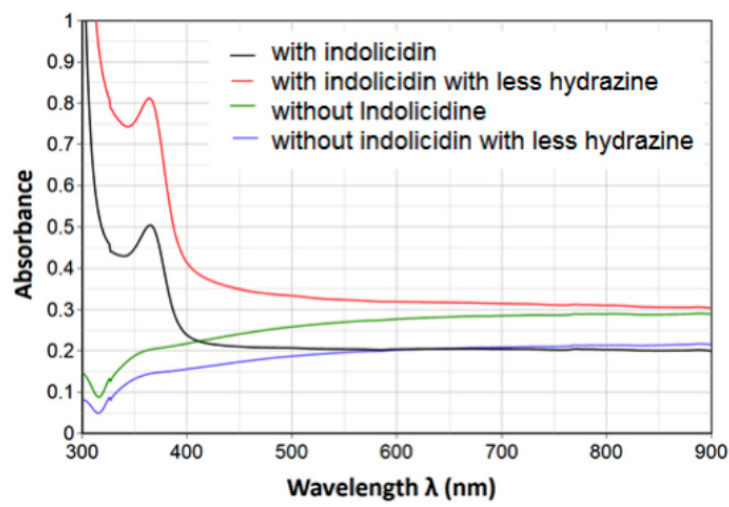
Figure 2. UV-Vis spectra of silver colloids prepared using 150 µ L and 10 µ L N 2 H 4 · H 2 O in the presence of indolicidin. UV-Vis spectra of silver colloids prepared using 150 µ L and 10 µ L N 2 H 4 · H 2 O without indolicidin indicated in light blue.